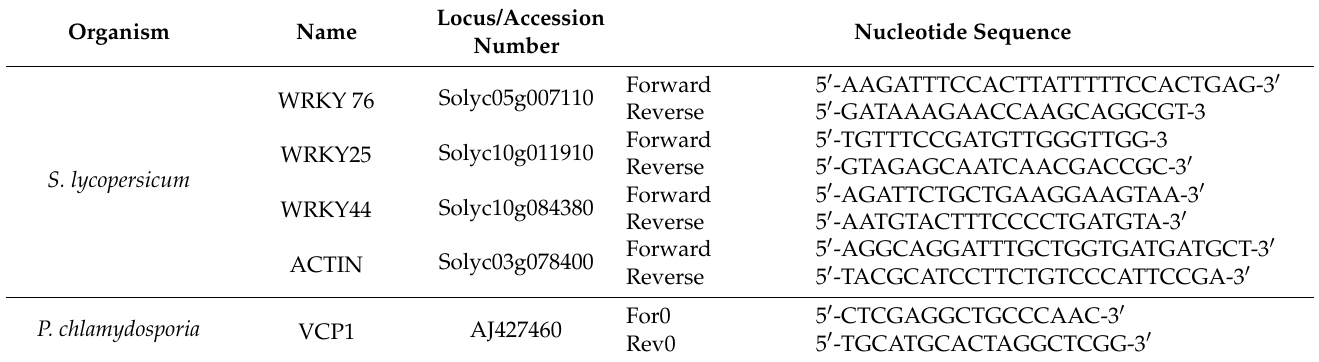
Table 4. Primer description used for qPCR